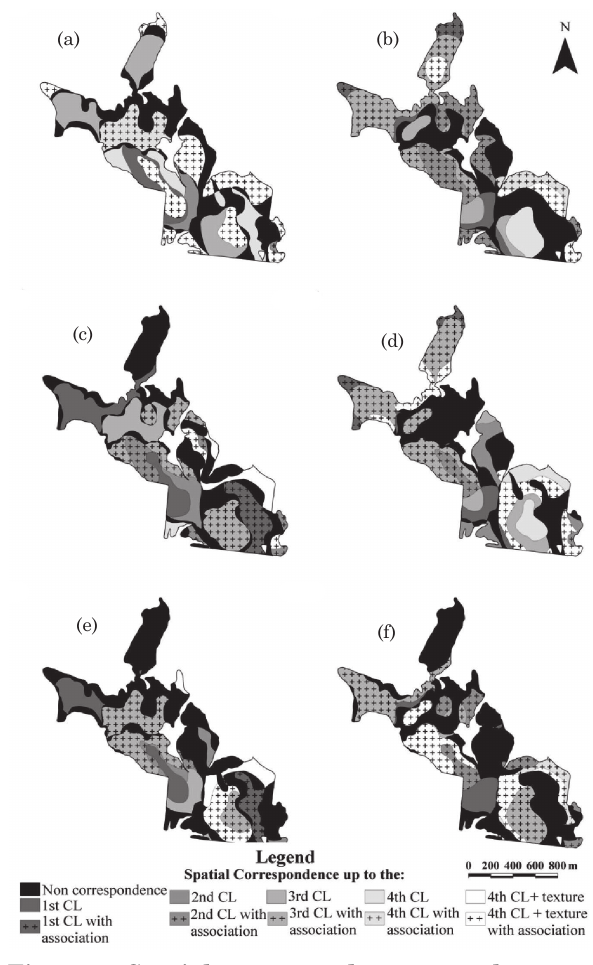
Figure 3. Spatial correspondence maps between conventional maps: a) A and B; b) A and C; c) A and D; d) B and C; e) B and D; and f) C and